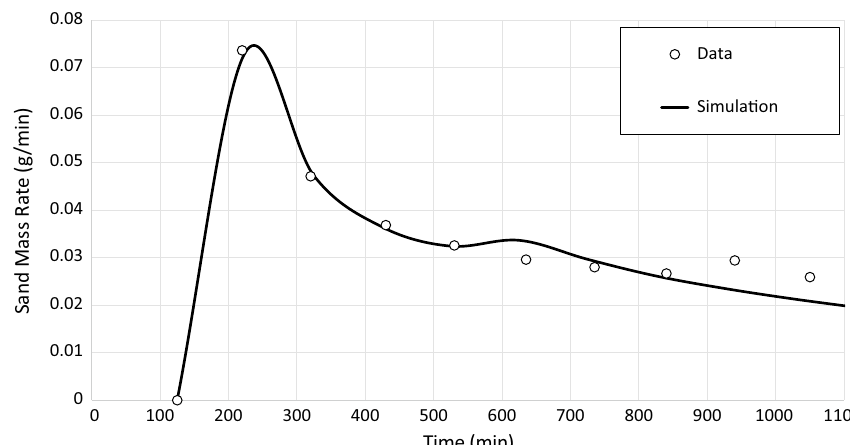
Fig. 17 Comparison between numerical simulation results and experimental data on pro- duced sand mass rate